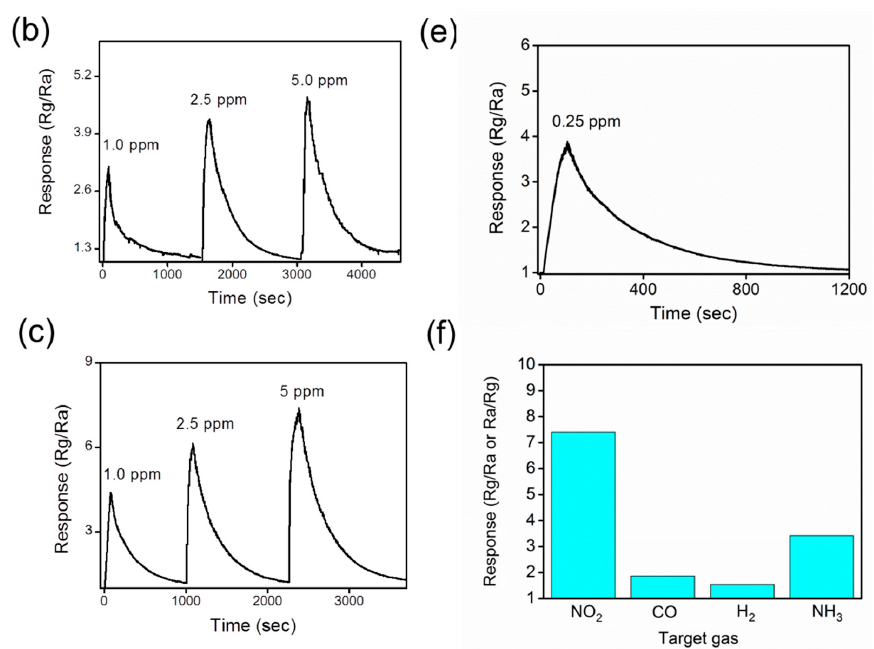
Figure 7. Gas sensing response curves of various samples on exposure to various concentrations of NO 2 gas (1.0, 2.5, and 5.0 ppm) at various temperatures: ( a ) CdO film at 325 °C; ( b ) TiO 2 rods at 275 °C; ( c ) TiO 2 –CdO rods at 275 °C; ( d ) Gas sensing response values vs. NO 2 gas concentration for various samples; ( e ) Gas sensing response curve of the TiO 2 –CdO rods on exposure to 0.25 ppm NO 2 gas; ( f ) Gas sensing selectivity histogram of the TiO 2 –CdO rods tested to 5 ppm NO 2 and 100 ppm of CO, H 2 , and NH 3 . Table 1. Comparisons of NO 2 gas-sensing performance of various low-dimensional, TiO 2 –based composites.